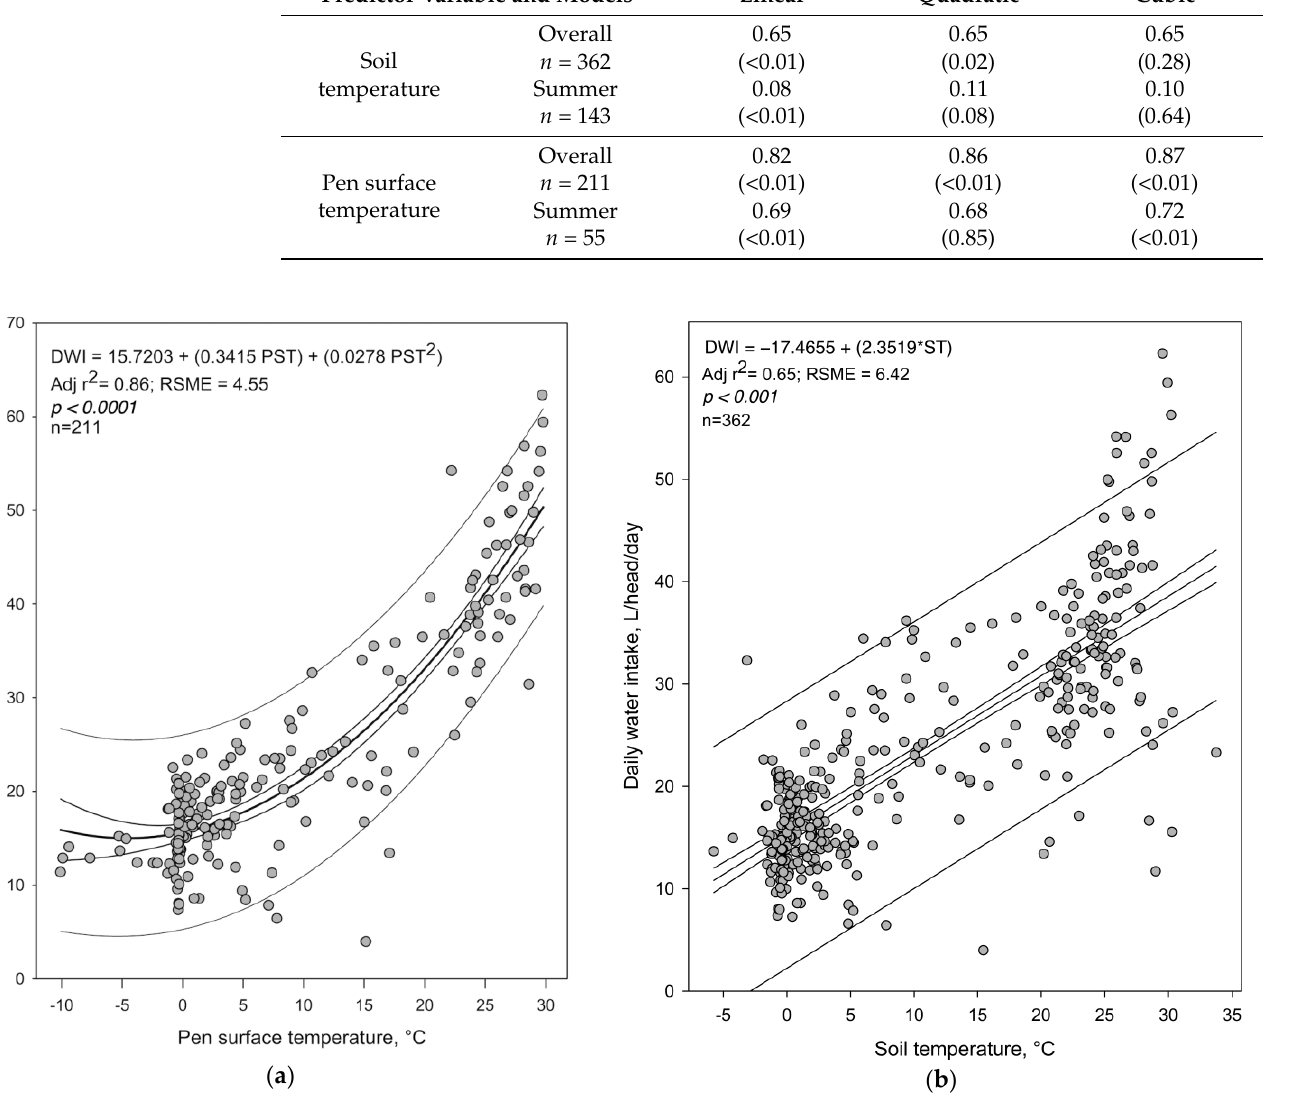
Table 1. Adjusted coefficients of determination ( p - values) for models’ prediction of daily water in- take (DWI) using soil temperature and pen surface temperature.